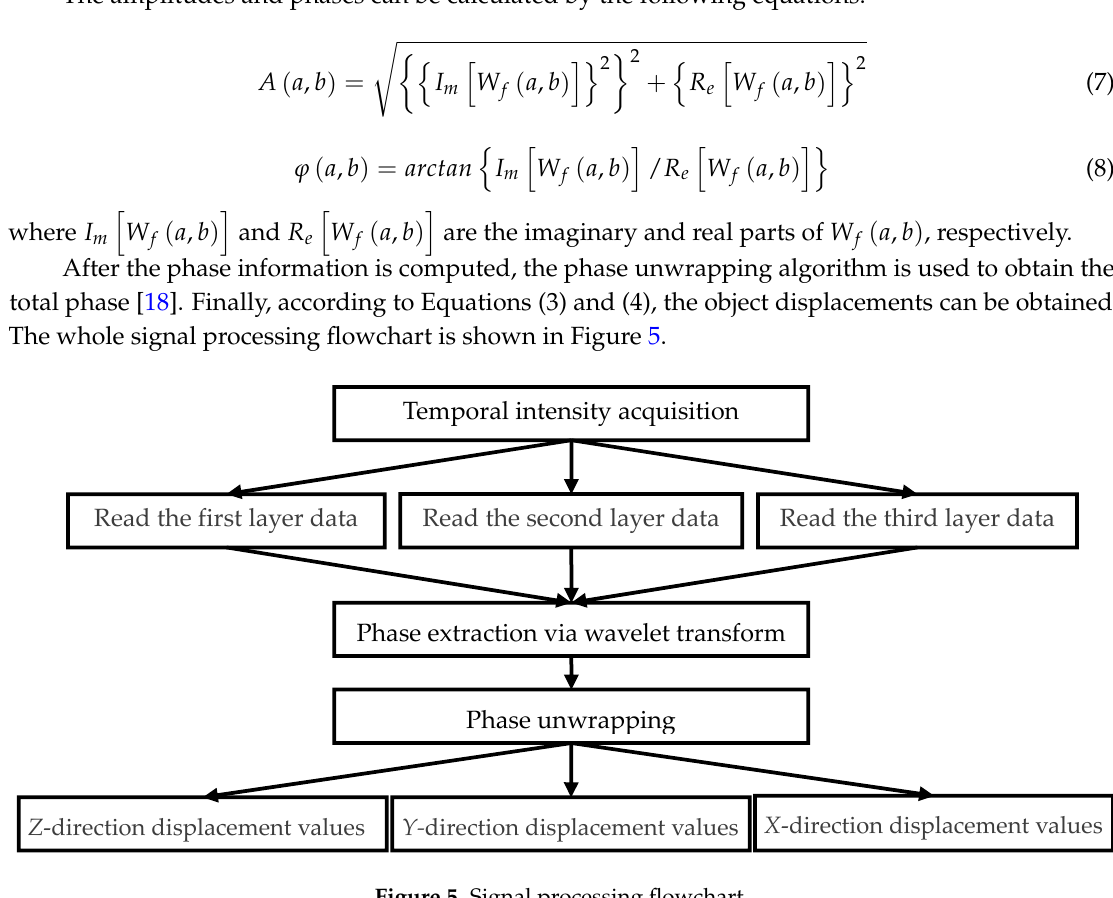
Figure 5. Signal processing flowchart.